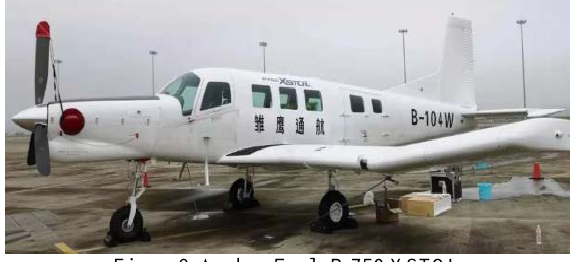
Figure 9. Anshan Eagle P-750